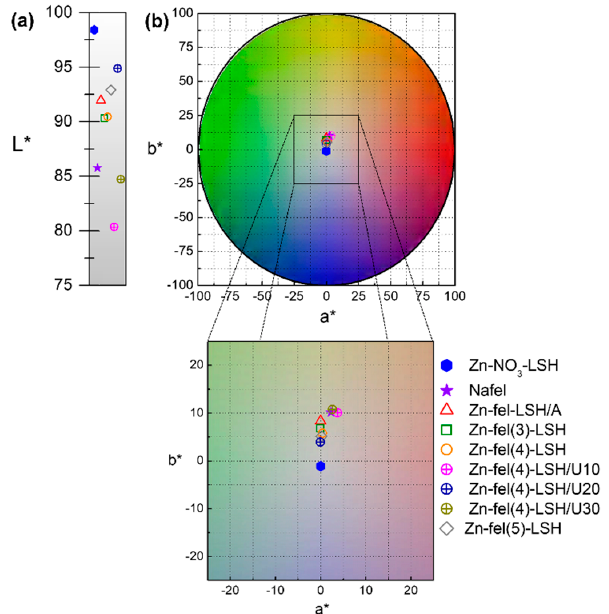
Figure 7. ( a ) Brightness scale; ( b ) Color scale corresponding to the CIELab color diagram of Zn-NO 3 -LSH matrix, Nafel salt (NaC 10 H 9 O 4 ), and LSH-ferulate materials. The absorption spectrum of the Zn-NO 3 -LSH matrix (Figure 8) shows broad bands with maximum values at 220, 251, 287, and 296 nm, which are assigned to electronic transi- tions of the nitrate anions intercalated [47,48]. This spectrum also exhibits an absorption band at 345 nm attributed to VB → CB transitions of the zinc hydroxide layers. The Nafel spectrum (Figure 8) presents characteristic absorption bands of hydroxycinnamic com- pounds situated in the 210–280 nm region, which are assigned to π → π * electronic transi- tions [49,50]. In addition, a broad and intense band at 325 nm attributed to a mixture of π → π * and n → π * transitions [49,50] is observed. These last electronic transitions correspond to carboxyl group and π -aromatic system of the ferulate anion. Figure 8. Absorption spectra of Zn-NO 3 -LSH, Zn-fel-LSH/A, Zn-fel(3)-LSH, Zn-fel(4)-LSH, Zn-fel(5)-LSH, and Nafel salt (NaC 10 H 9 O 4 ).